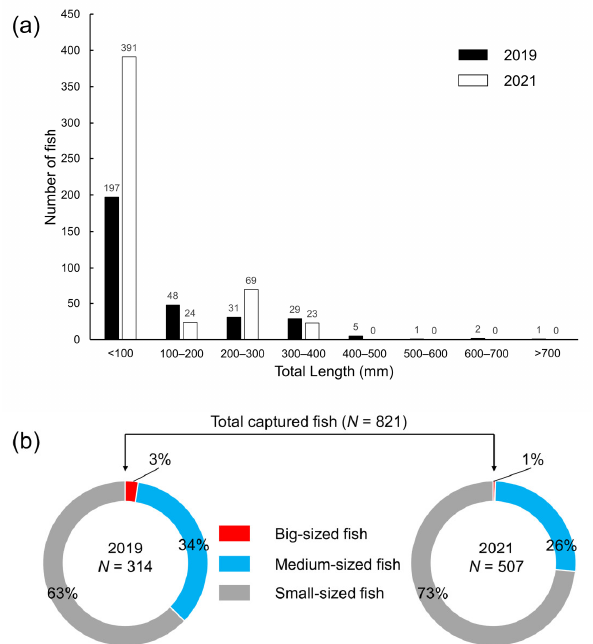
Figure 4. Distribution of ( a ) total length and ( b ) (wet) body weight of fish captured by traps in the NLP between 2019 and 2021.